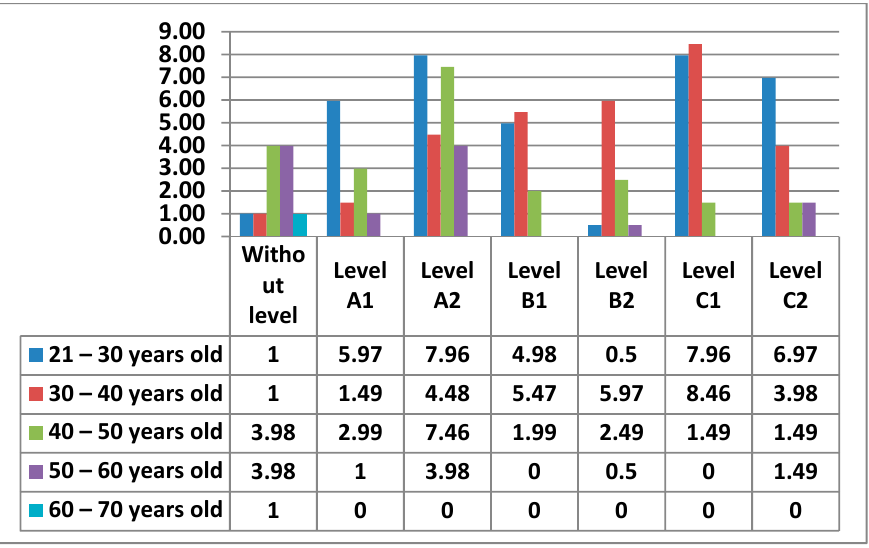
Figure 19. Digital competence in teachers by age in Area 3.